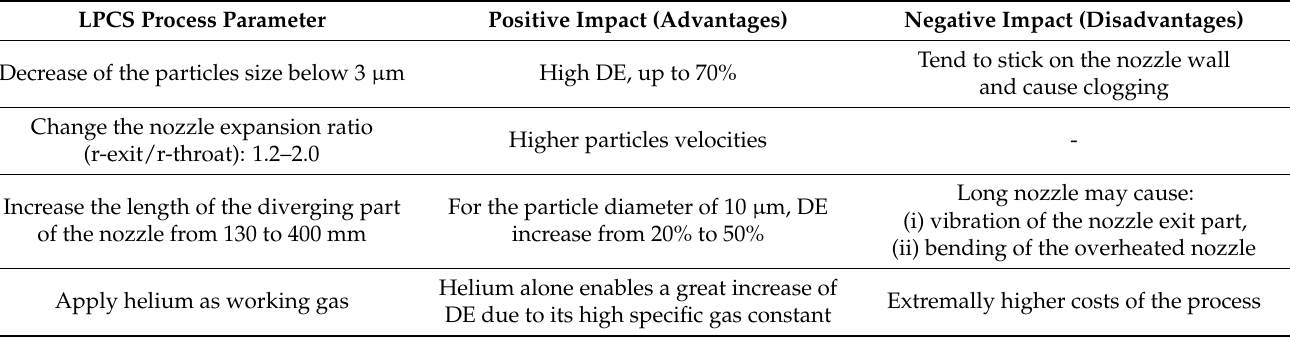
Table 1. Influence of LPCS parameters on the DE (inspired by Raoelison et al. [69]). LPCS Process Parameter Positive Impact (Advantages) Negative Impact (Disadvantages) Tend to stick on the nozzle wall High DE, up to 70% and cause Decrease of the particles size below 3 µm Change the nozzle expansion ratio (r-exit/r-throat): 1.2–2.0